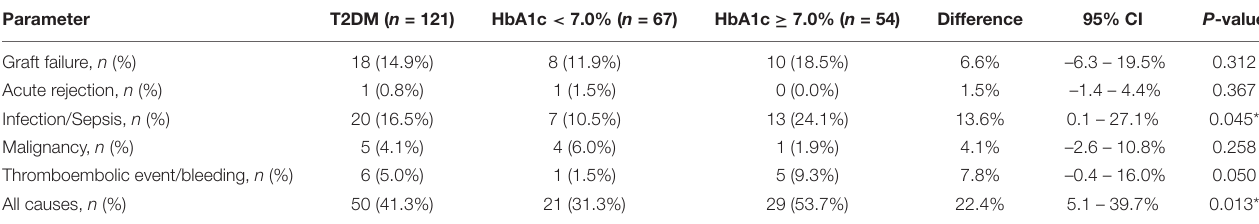
TABLE 7 | Causes of death within 5 years after HTX – stratified by HbA1c at HTX.